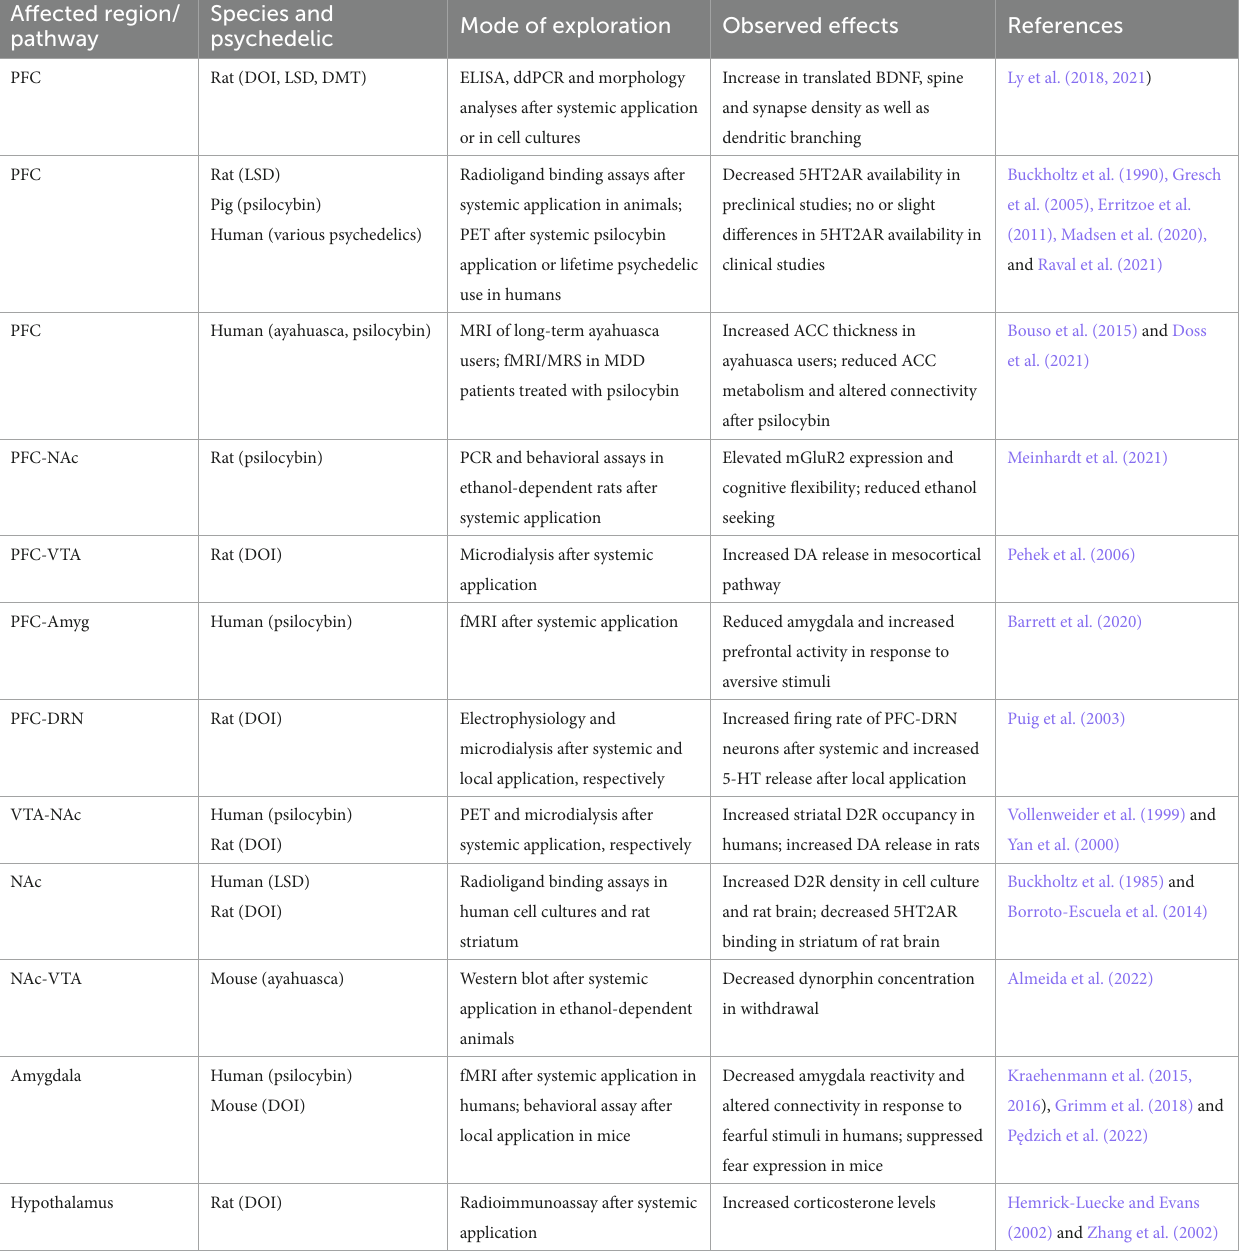
TABLE 1 Experimental evidence for psychedelic effects in key regions and pathways in the addicted